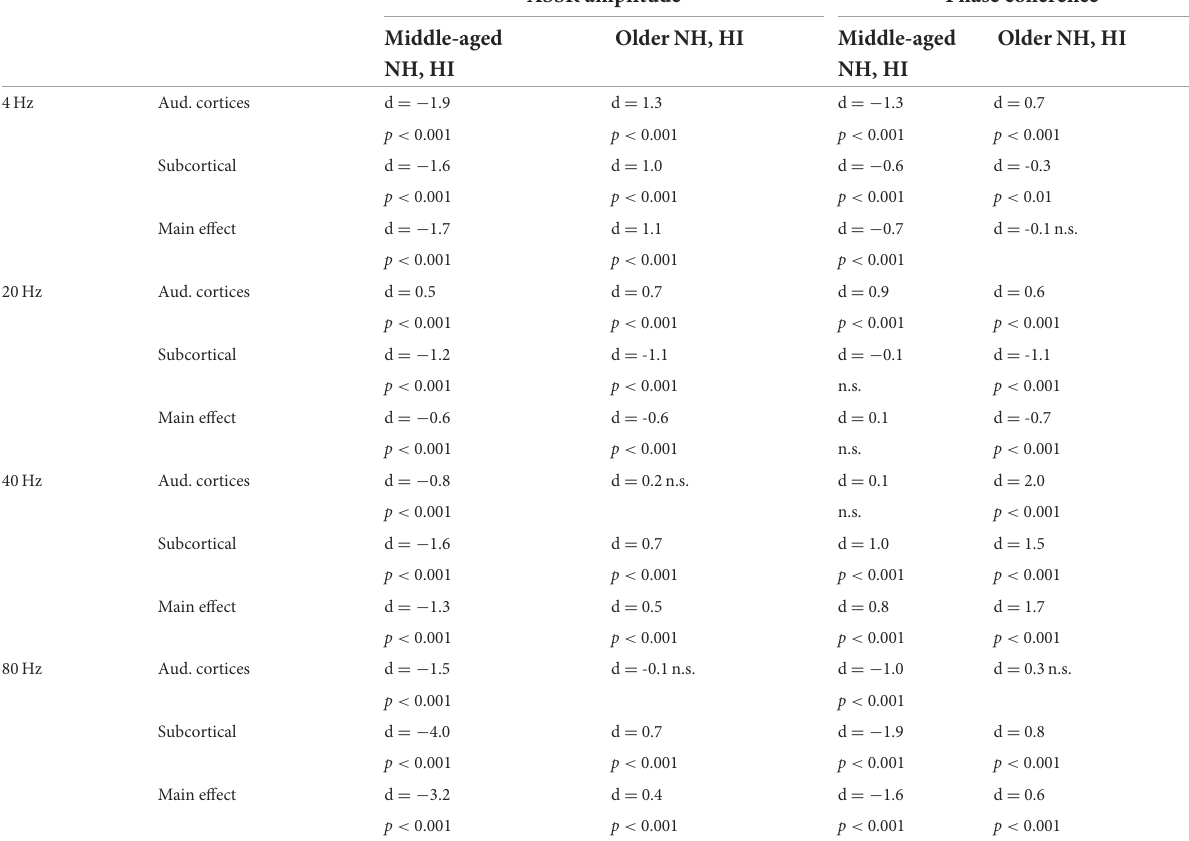
TABLE 1 The results of the main effect of hearing impairment and post-hoc testing for ASSR amplitude and phase coherence. ASSR amplitude Phase coherence Middle-aged Older NH,